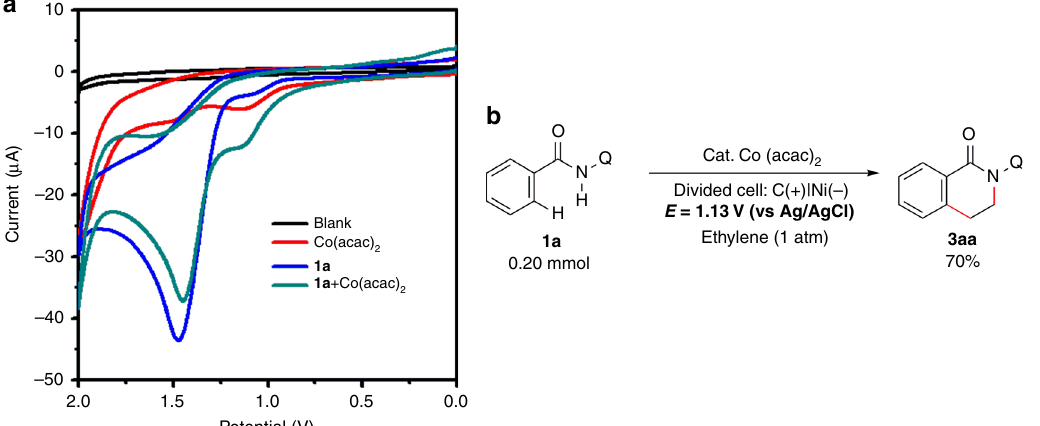
Fig. 6 Study of the oxidation potential during the electrolysis. a Cyclic voltammograms in CF 3 CH 2 OH (10 mL) with 0.06 M n Bu 4 NBF 4 : blue line, 1a (0.050 mmol); red line, Co(acac) 2 (0.050 mmol); green line, a mixture of Co(acac) 2 (0.050mmol), and 1a (0.050 mmol). b Potential controlled electrolysis at